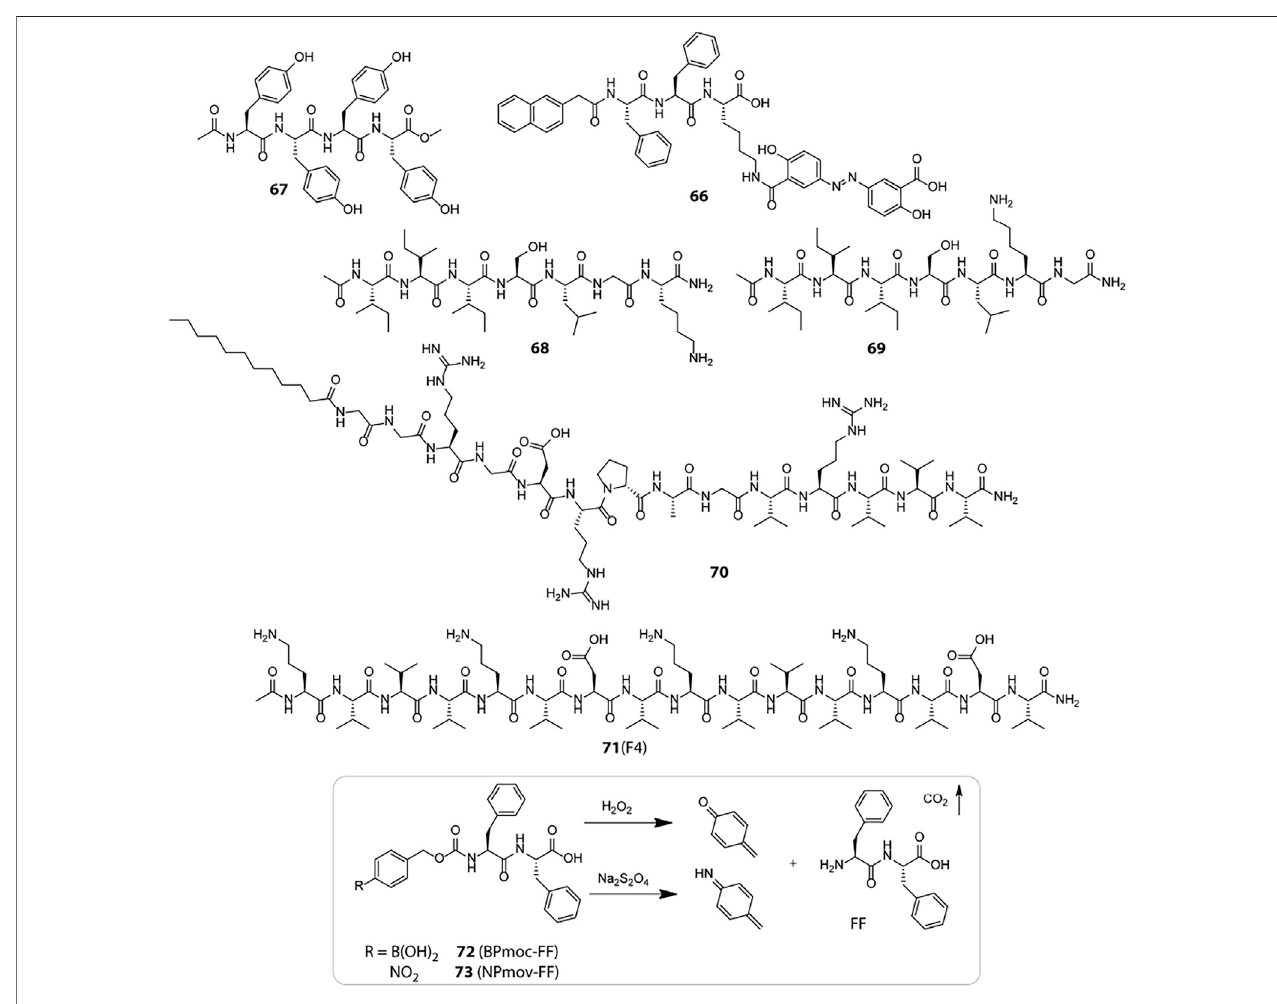
Scheme 3 | Chemical structures of representative bio-responsive peptide based smart hydrogelators used for therapeutic applications.